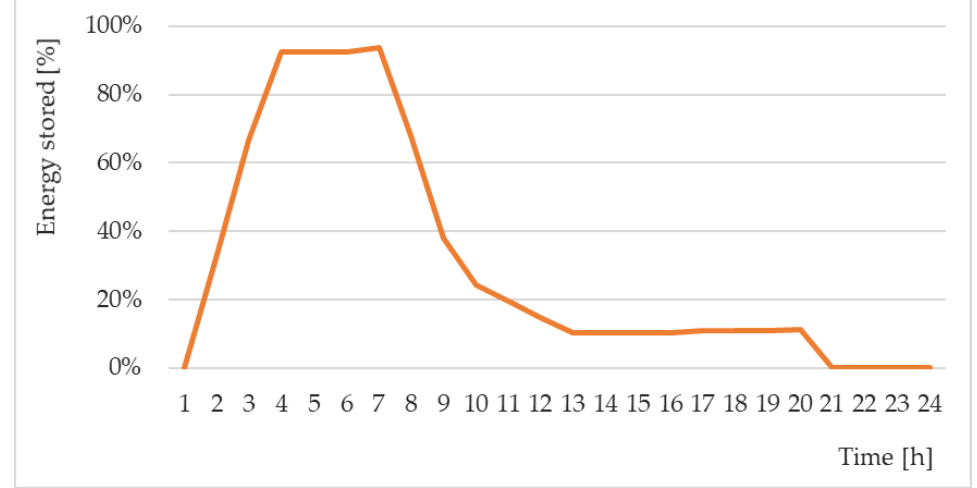
Figure 12. Results of the additional simulation—energy stored in the energy storage (ES) assuming lower costs of ES.